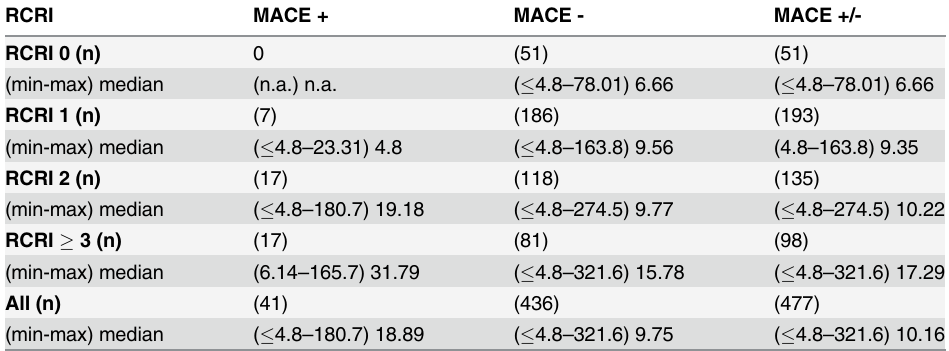
Table 4. Preoperative Copeptin levels (pmol/L) in patients with or without MACE according to RCRI level.